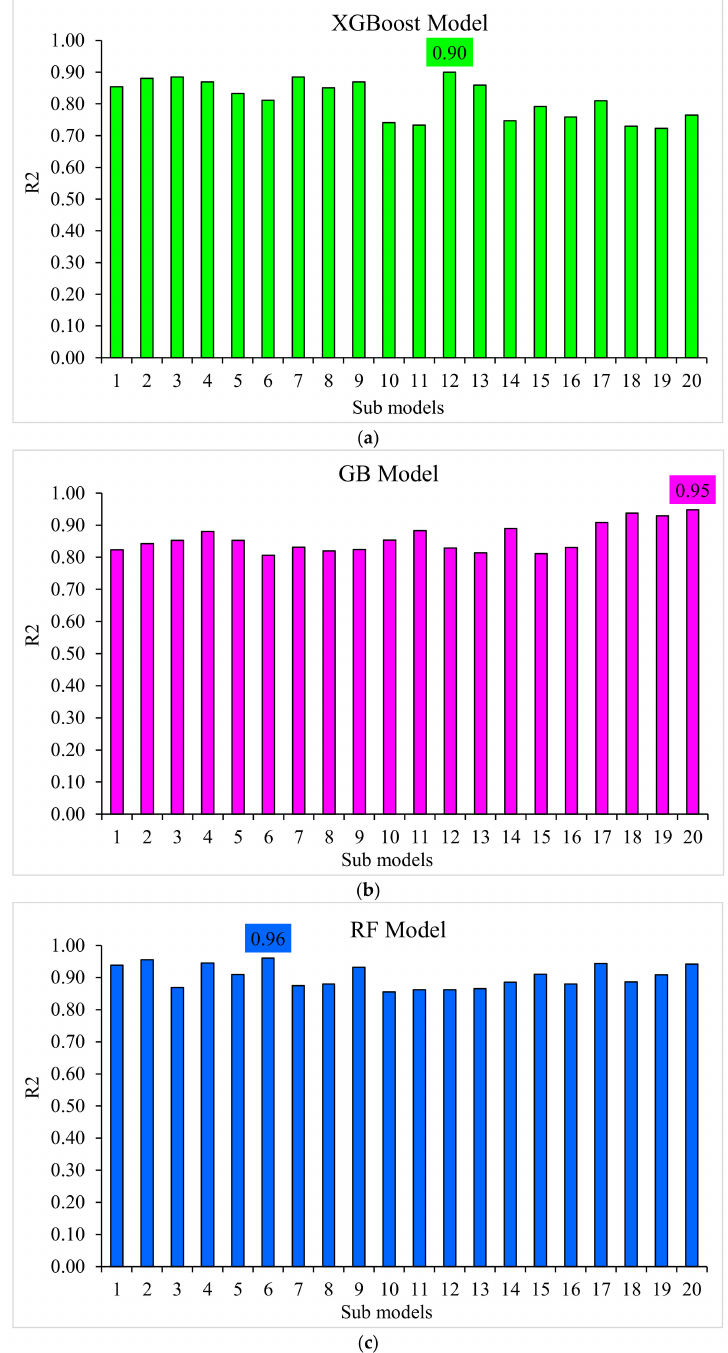
Figure 15. Submodel results: ( a ) XGBoost; ( b ) gradient boosting; and ( c ) random